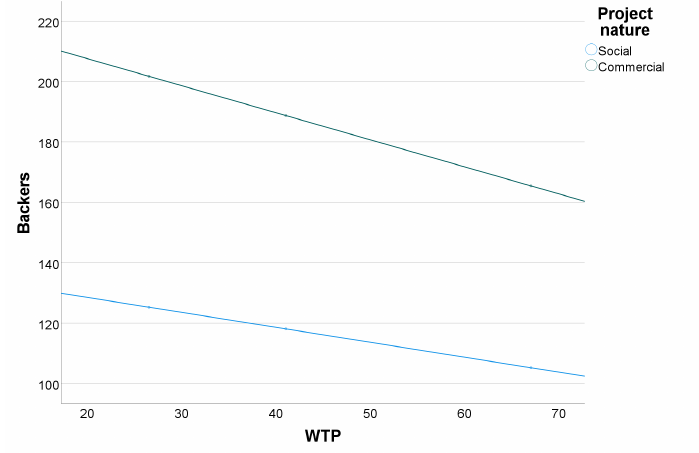
Figure 4. Relationships of Rewards-Backers and WTP-Backers by project